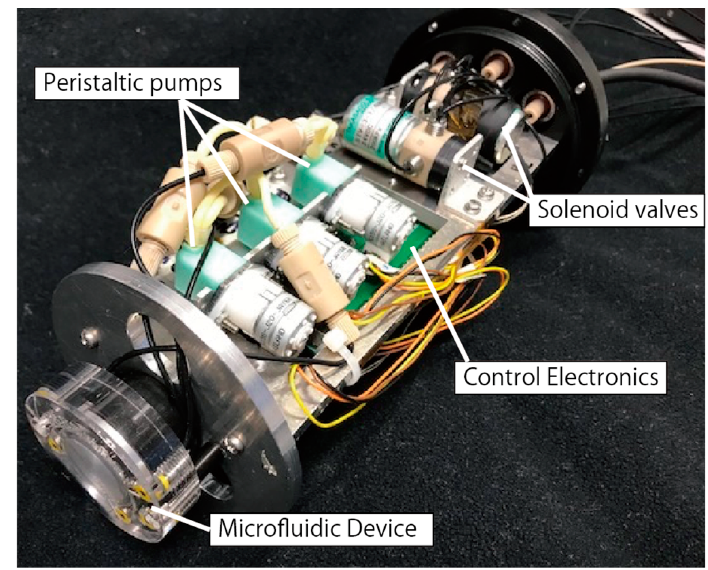
Figure 4. The analysis module for the in-situ ATP analyzer. Three peristaltic pumps and three solenoid-actuated three-way valves were employed as the pumping device.